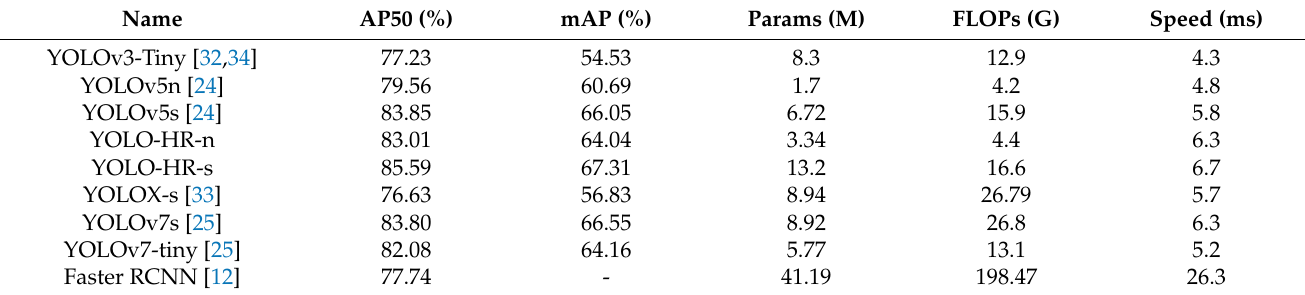
Table 5. Comparison with other algorithms.